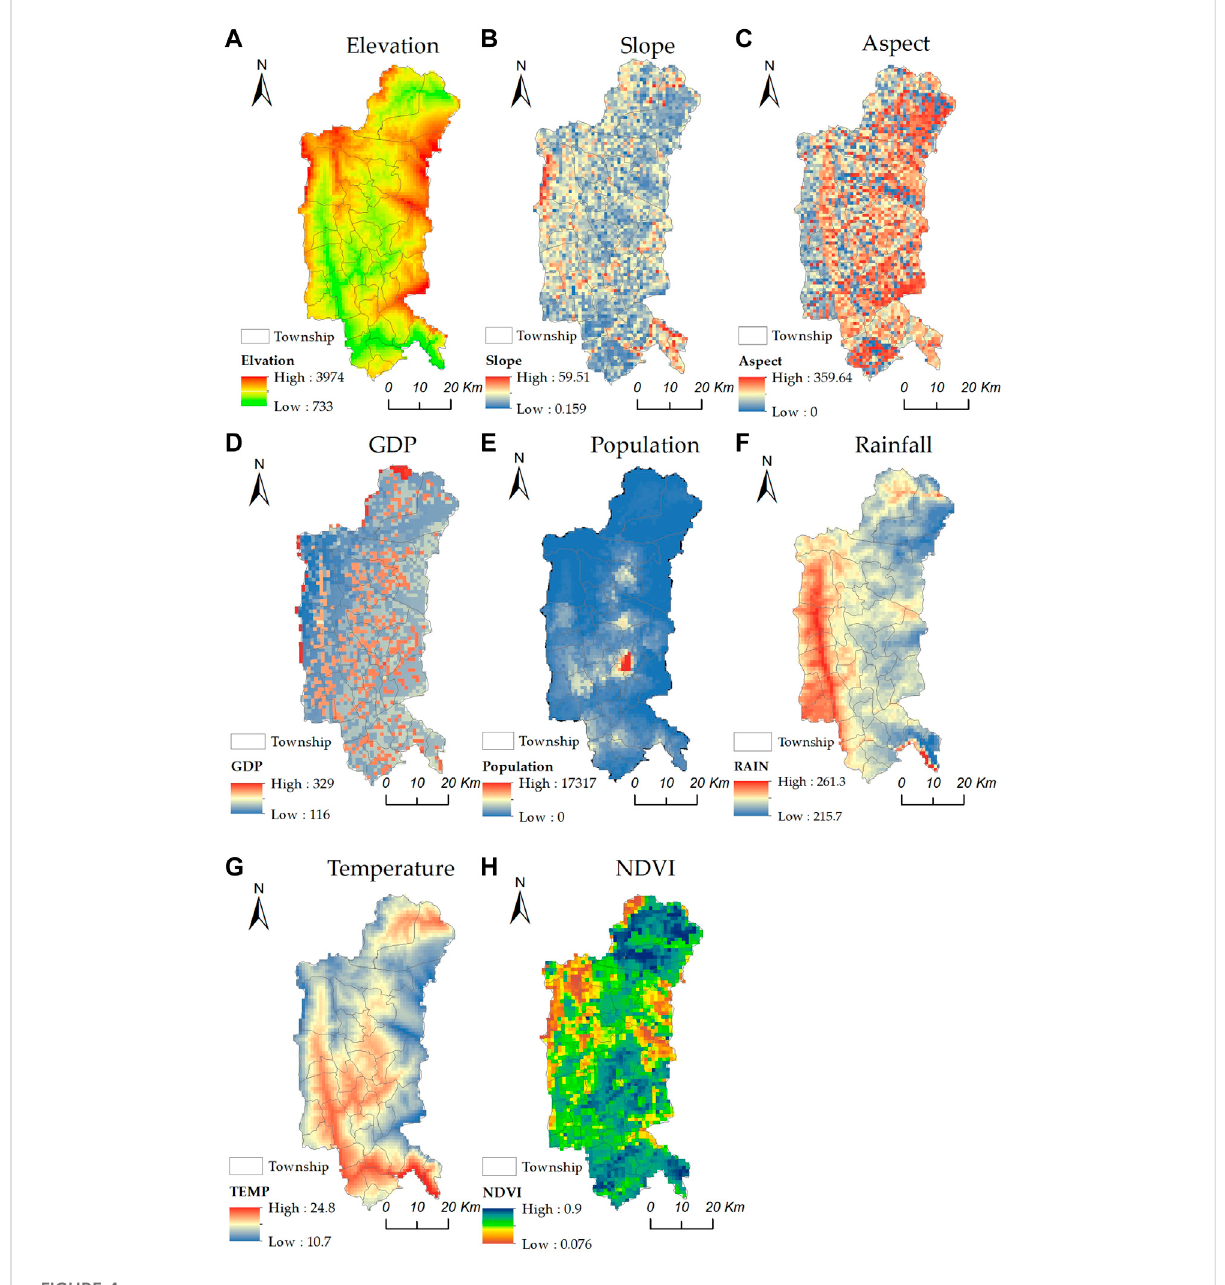
FIGURE 4 Spatial distribution of explanatory